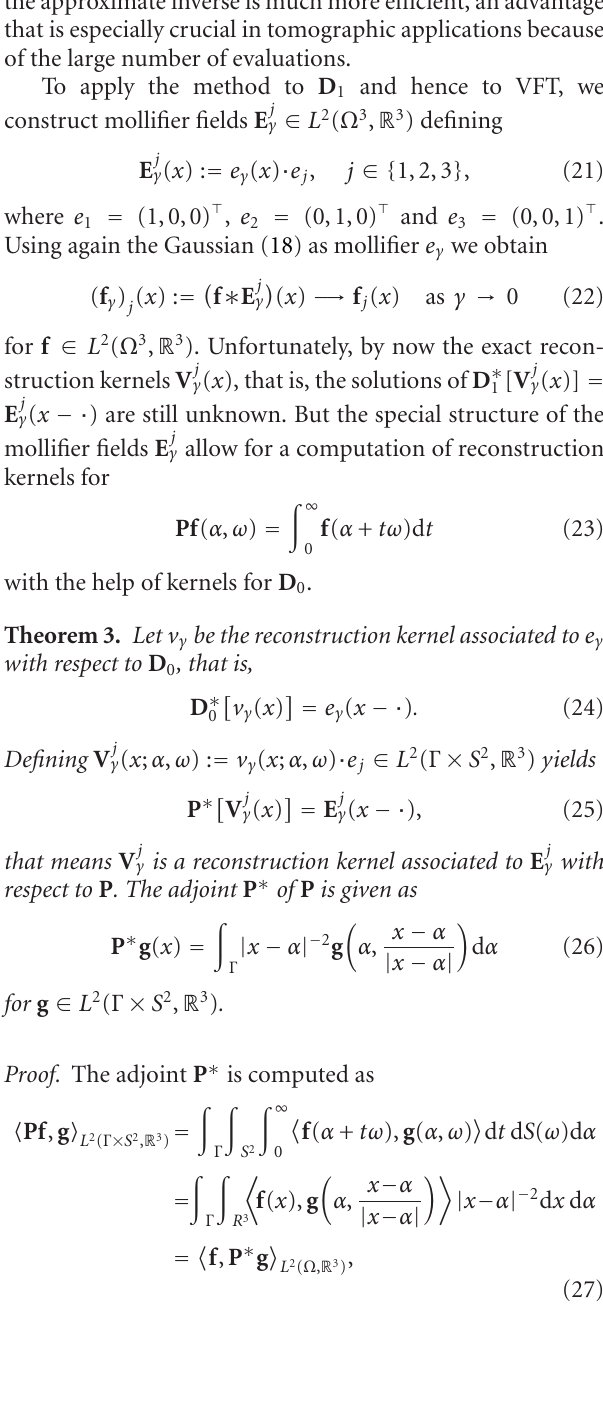
Algorithm 1: For cone beam